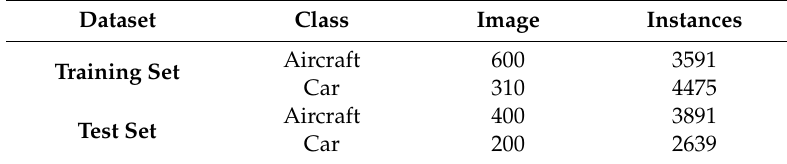
Table 6. Dataset of object detection in aerial images (UCS-AOD) dataset statistics.